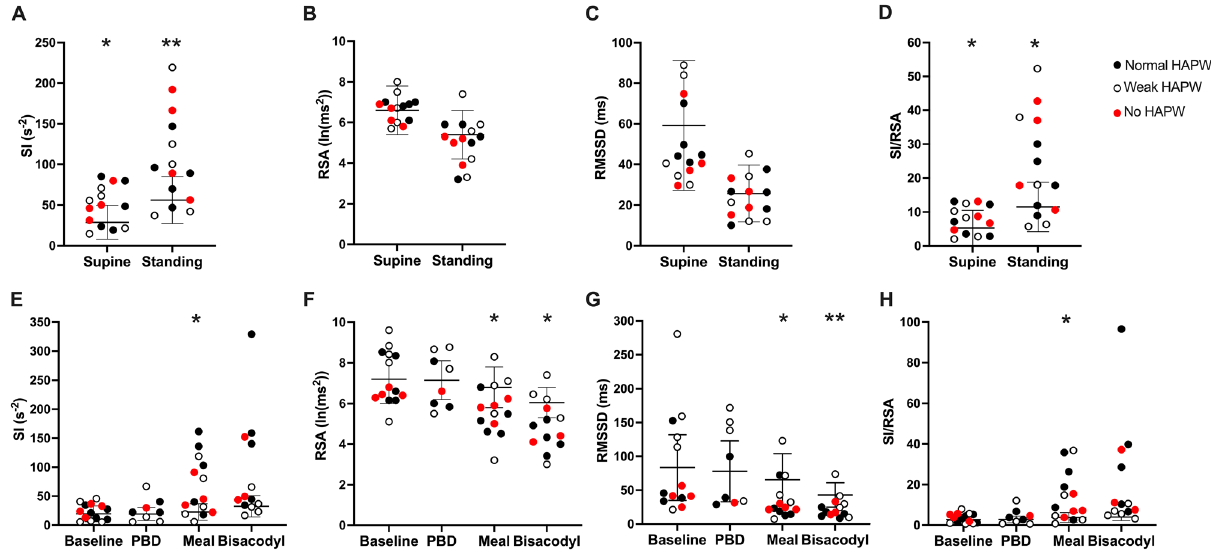
Figure 3. Comparison of autonomic nervous system activity in patients and healthy subjects. Patients are divided into three groups, those with normal HAPW activity (black), those with weak HAPW activity (open), those without HAPW activity (red). ( A – D ) Sympathetic (SI) activity, parasympathetic (RSA, RMSSD) activity, and autonomic balance (SI/RSA) during the active standing test for the assessment of general autonomic function. Active standing test controls: RSA and RMSSD N = 33, SI and SI/RSA N = 20. ( E – H ) Sympathetic (SI) activity, parasympathetic (RSA, RMSSD) activity, and autonomic balance (SI/RSA) during the HRCM procedure where autonomic functioning was assessed in quiescent periods during baseline and in response to stimuli. All lines represent mean ± SD of healthy subjects. HRCM controls: baseline and meal N = 10, PBD N = 8, rectal bisacodyl N = 9) 15 . Most patients show high sympathetic tone (supine) and high sympathetic reactivity in response to stimuli, from supine to standing, proximal balloon distention (PBD), 1000 kcal meal and rectal bisacodyl. Low RSA in response to the 1000 kcal meal and rectal bisacodyl was also present. SI = sympathetic index (Baevsky’s stress index). RSA = respiratory sinus arrhythmia, RMSSD = root mean square of successive differences between heartbeats. SI/RSA = Autonomic balance. High and low designations indicate values above or below 1SD of healthy subjects. Each dot represents one patient (N = 14). * P < 0.05, ** P <